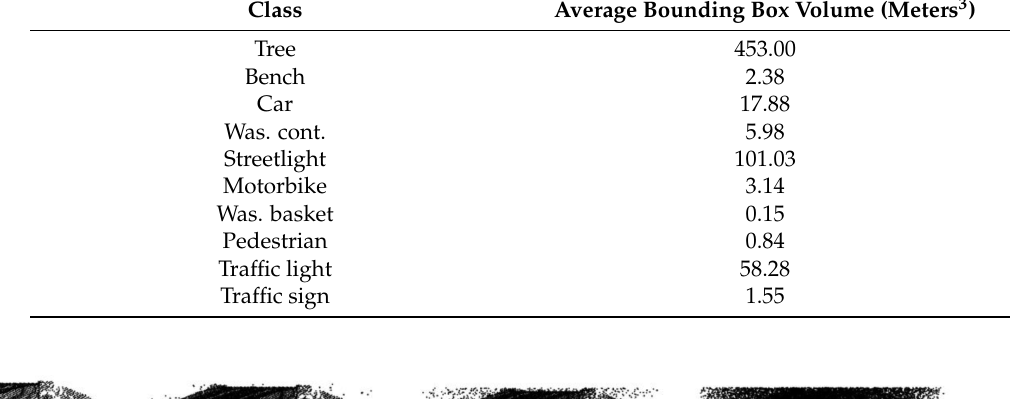
Table 5. Average volume per class object.